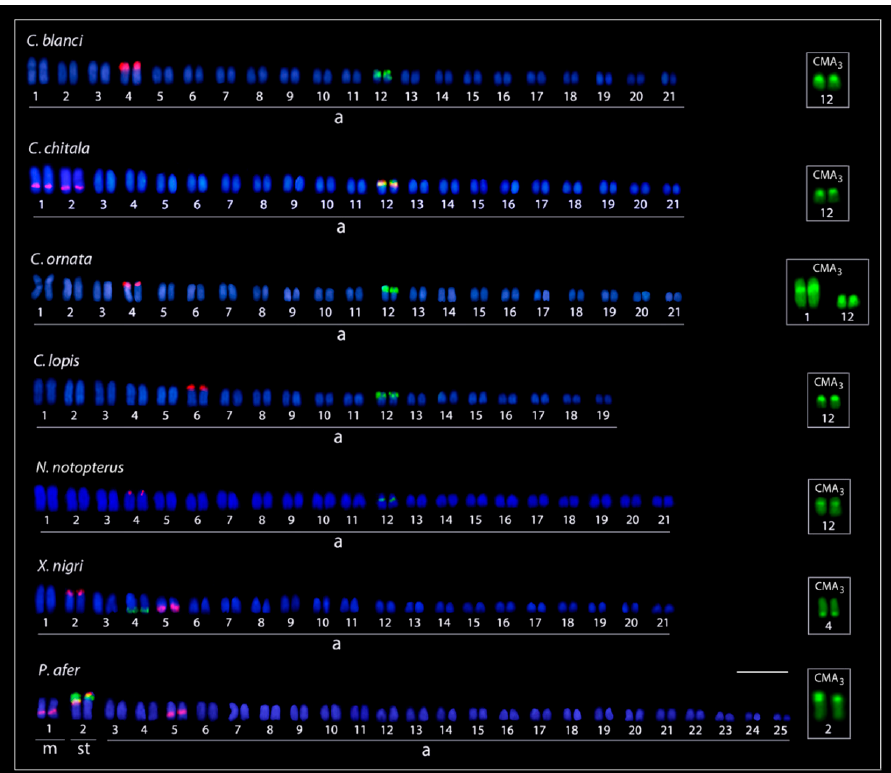
Figure 4. Karyotypes of seven species of Notopteridae analyzed after double fluorescent in situ hybridization (FISH) experiments with 18S (green) and 5S ribosomal DNAs (rDNAs) (red) as probes. The chromosomes evidencing GC-rich regions after Chromomycin A 3 staining are highlighted in boxes. Scale bar = 5 μ m.